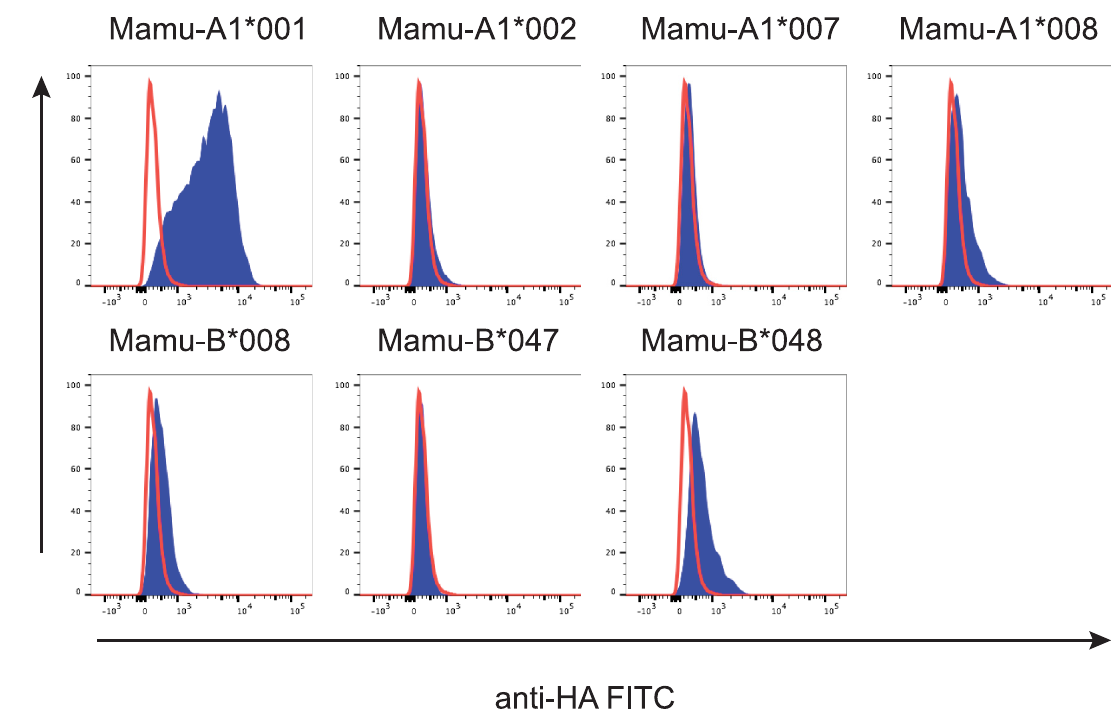
Fig 4. Testing the specificity of P12 against a panel of MHC class I transferents. P12 was incubatedwith MHC class I transferents expressingcommon Mamu-A and Mamu-B alleles(blue traces) and the MHC class I-null cell line 721.221(red traces). Cell-bound Fab fragments were detected with FITC-labeled anti-HA